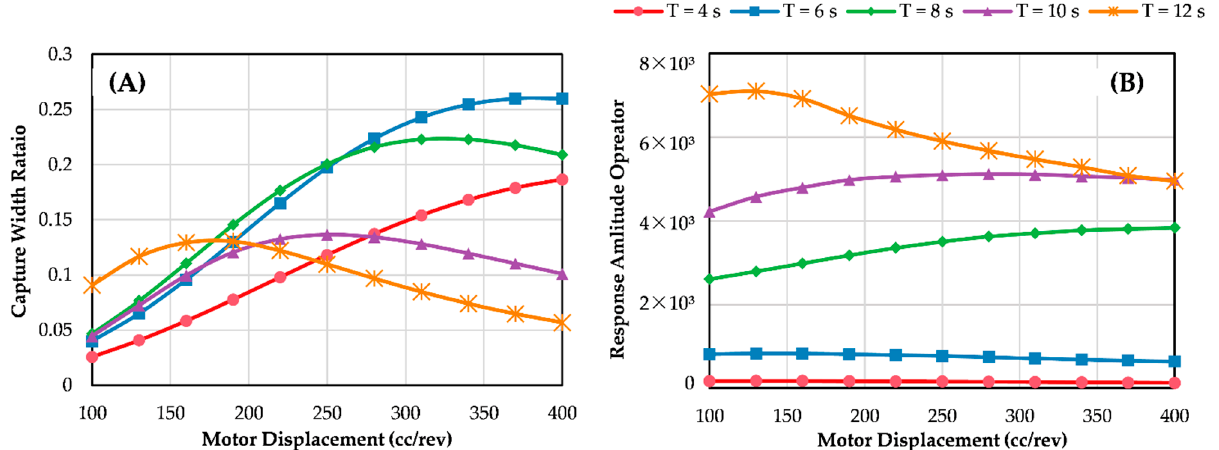
Figure 12. Influence of displacement of hydraulic motor on the performance of the hybrid system under wave height of 1.5 m. ( A ) Variation of CWR. ( B ) Variation of pitch motion RAO. Further investigation will be carried out about the variation of the optimal displace- ment of hydraulic motor and their corresponding performance under different wave states. Here the displacement of hydraulic motor to achieve the peak CWR is denoted by